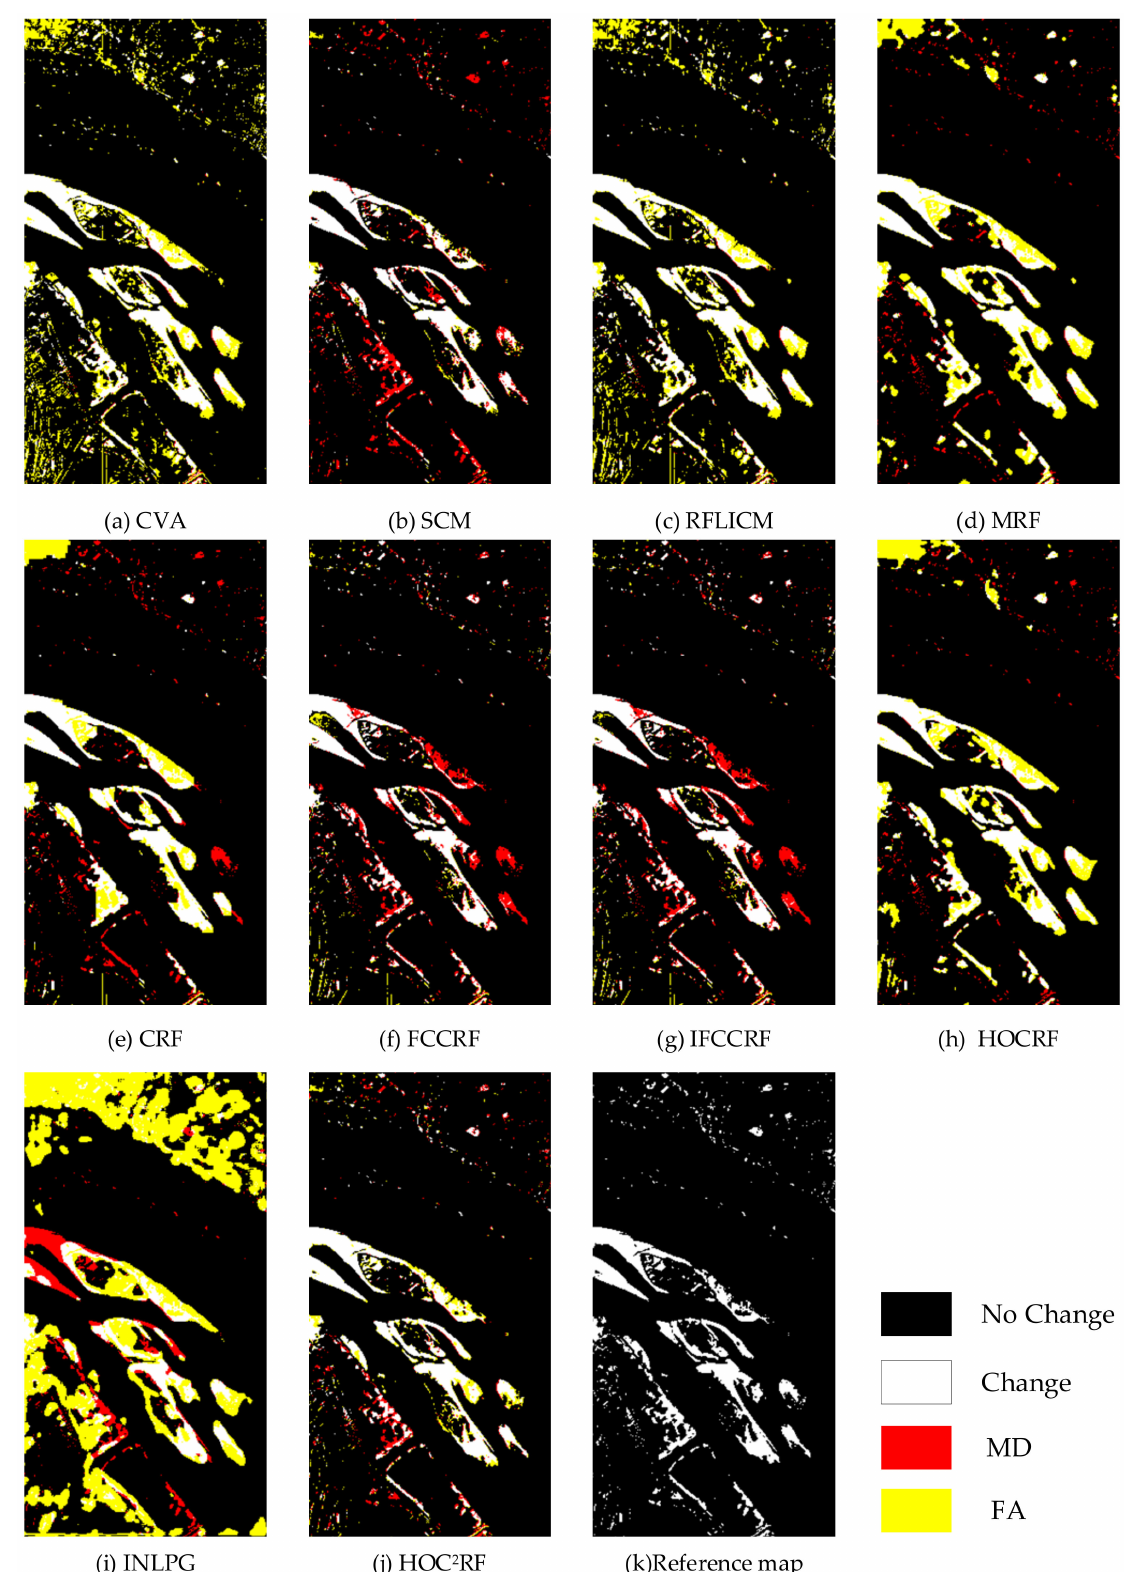
Figure 8. CD maps produced by different methods for the Poyang River